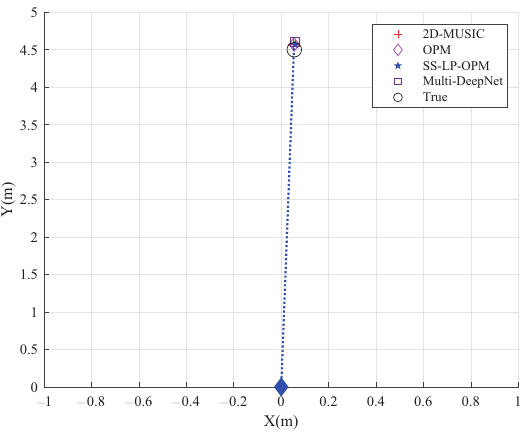
Figure 17. Localization result of Scenario 1.